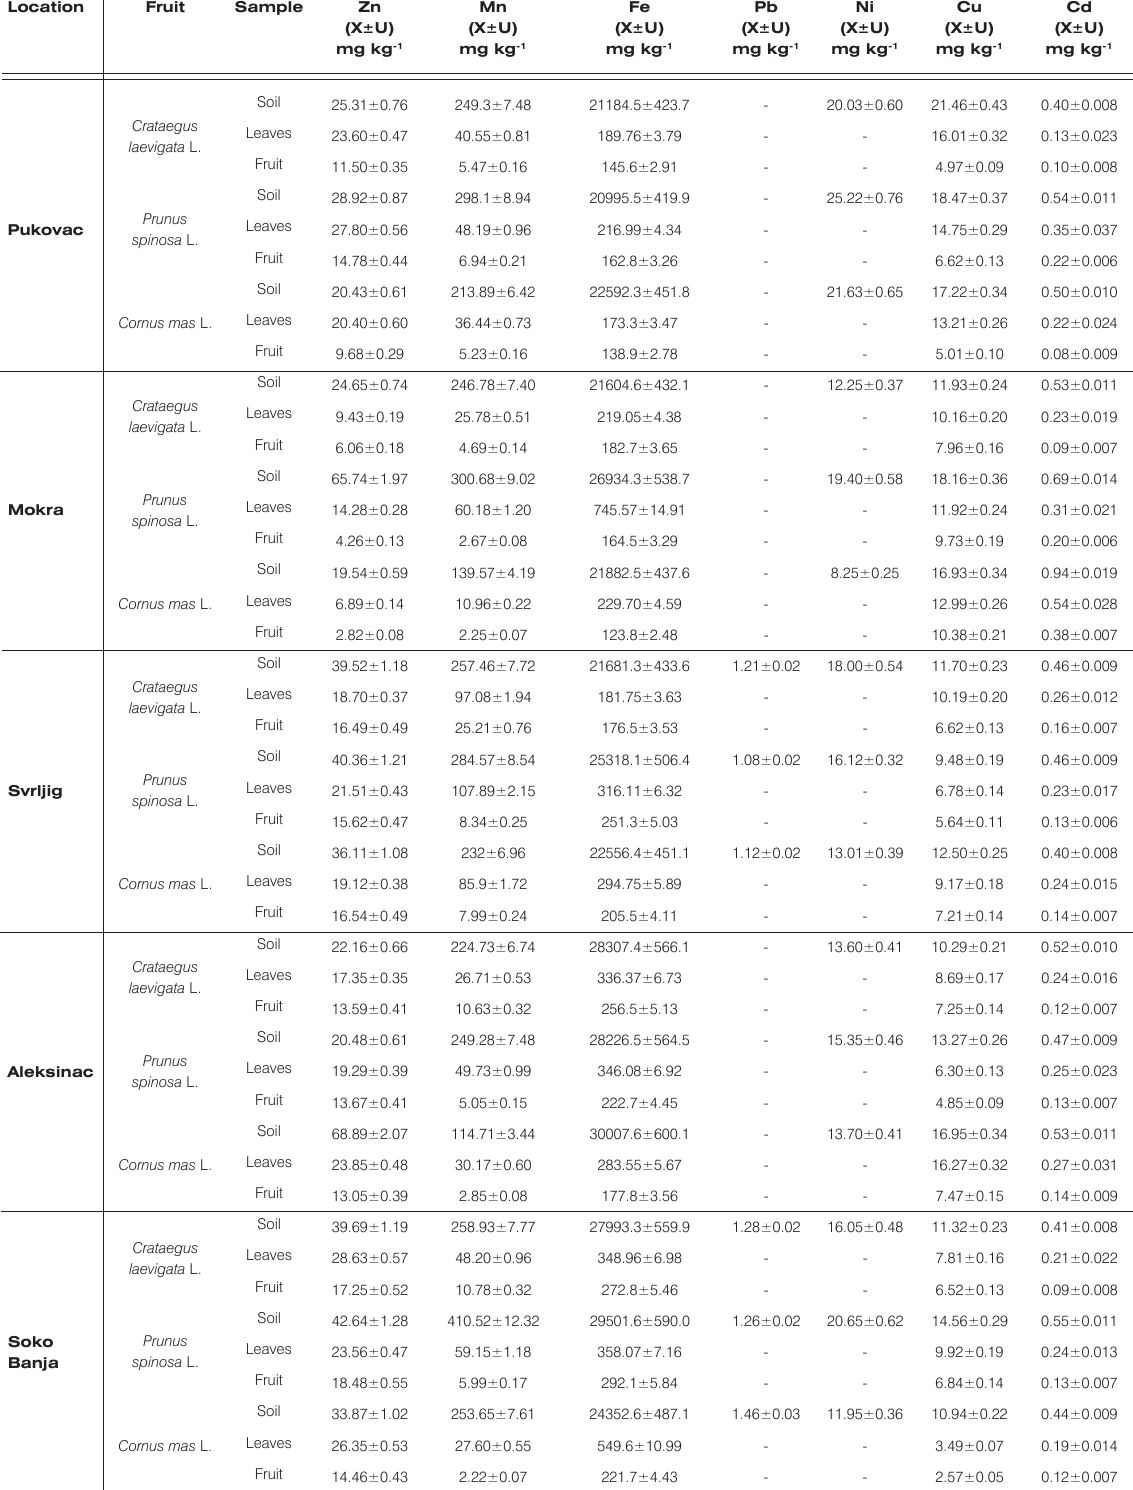
Table 3. Mean metal concentrations in soil, leaves and wild fruit.